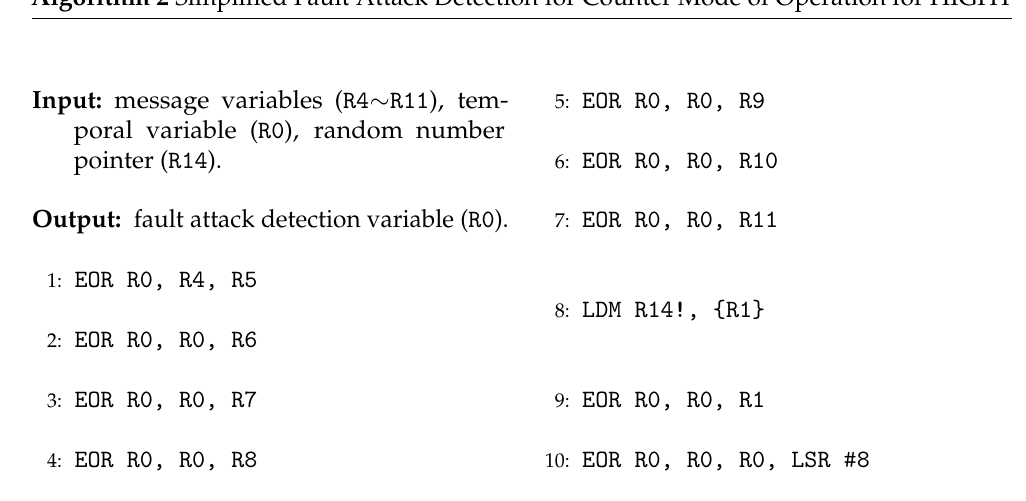
Algorithm 2 Simplified Fault Attack Detection for Counter Mode of Operation for